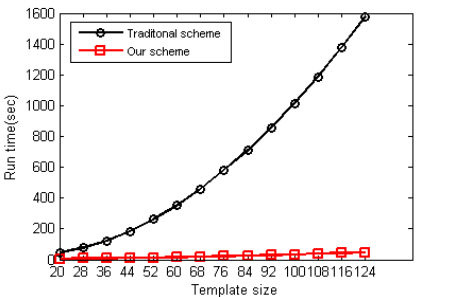
Figure 10. The run time of the traditional match scheme and our scheme using HOPC with increased template sizes.